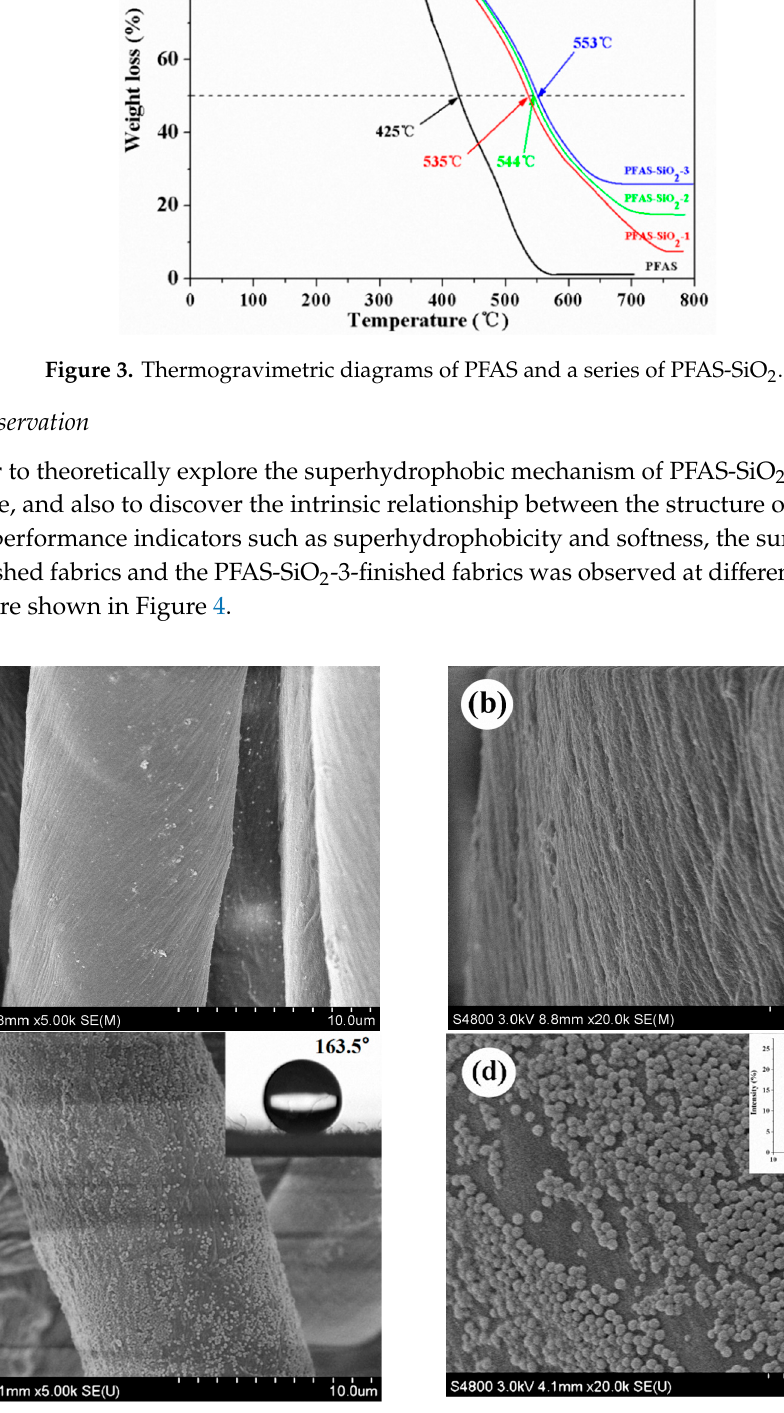
Figure 4. SEM images of unfinished fabric at ( a ) ×5000 and ( b ) ×20,000 and of PFAS-SiO 2 -3-finished fabric at ( c ) ×5000 and ( d ) ×20,000.